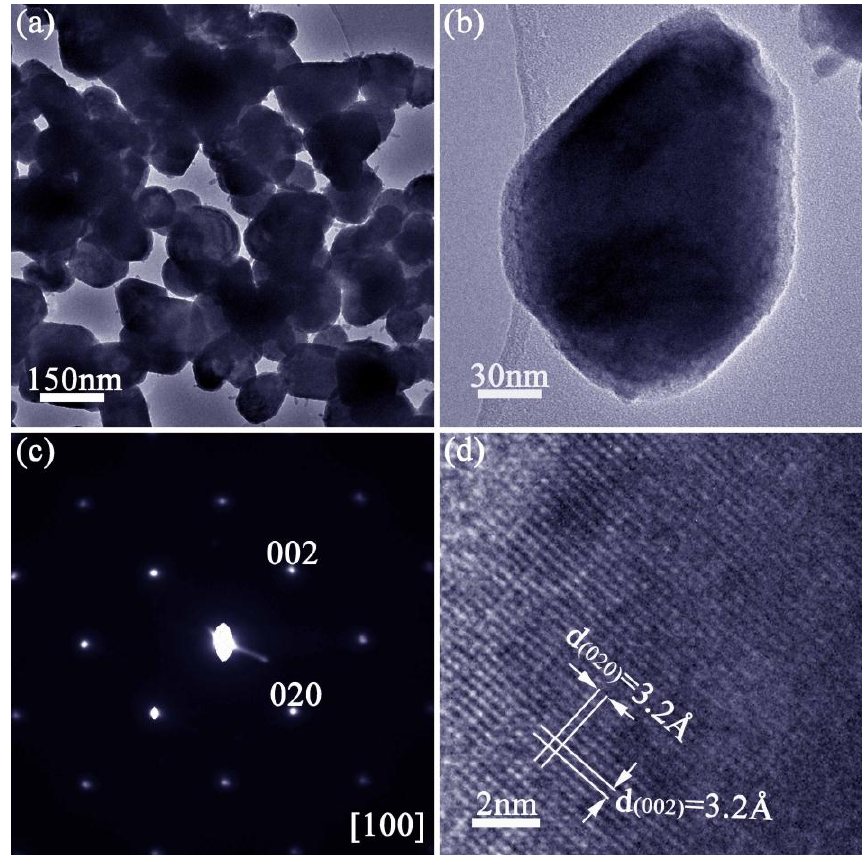
Figure 2. TEM characterisation of SnTe nanoparticles synthesised after 2 h: ( a , b ) TEM images of a group of nanoparticles and a single particle respectively; ( c ) SAED pattern collected from the particle in ( b ); ( d ) corresponding HRTEM image taken from the same particle.